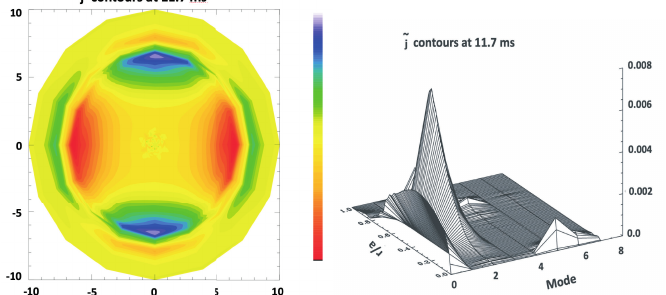
Figure 7. Left: The contour plots of the current density fluctuations ˜ j at t = 11.7 ms corresponding to the saturated level with M S = 10 − 1 , Pr = 1. Right: The corresponding spectra of the current density fluctuations ˜ j as functions of ρ and poloidal mode number m